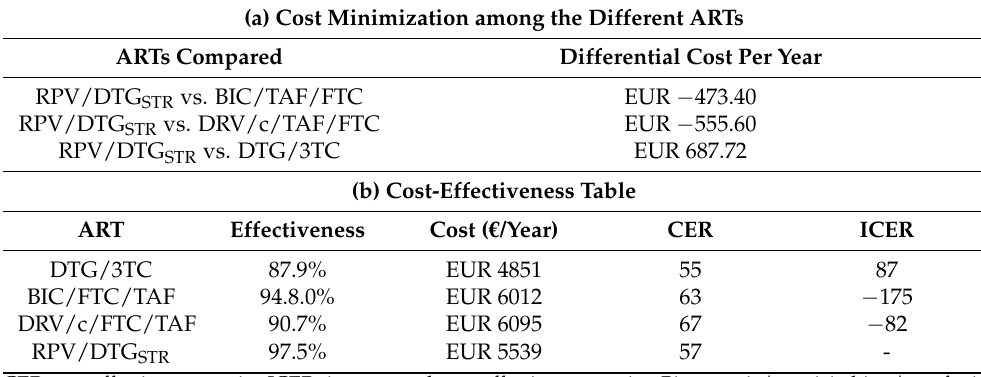
Table 5. (a) Cost minimization among the different ARTs. (b) Cost-effectiveness table. (a) Cost Minimization among the Different ARTs ARTs Compared Differential Cost Per Year